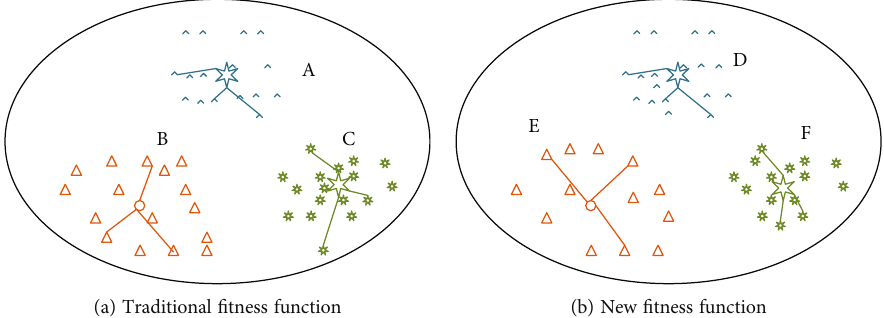
Figure 4: Clustering results of old and new fi tness functions in the same data set.